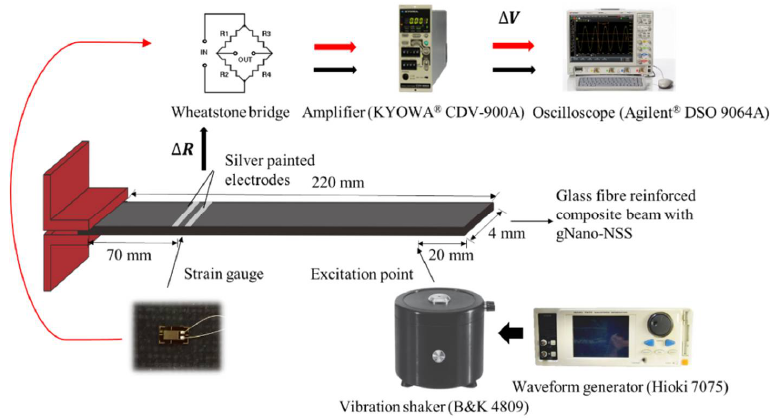
Figure 9. Experimental setup of dynamic vibration test with simultaneous measurement of resistance change in a local gNano-NSS and a counterpart strain gauge.